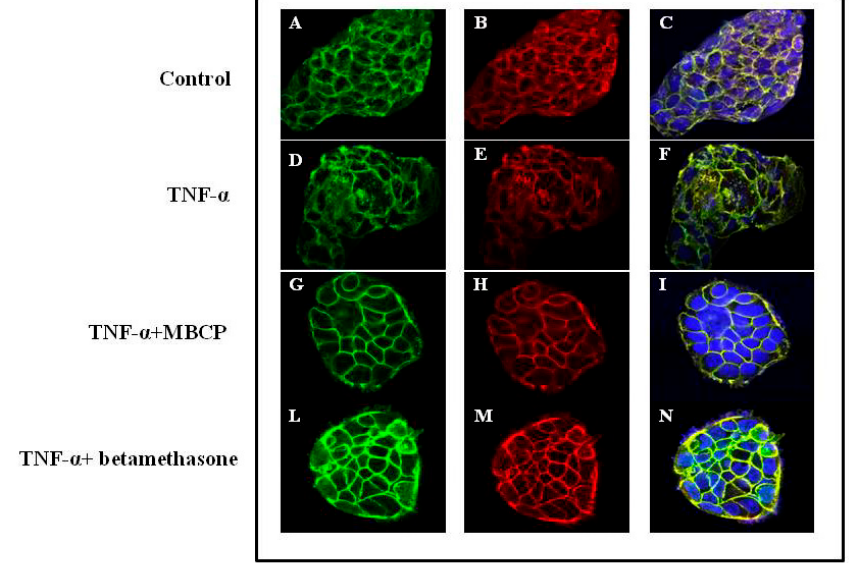
Figure 3. MBCP ameliorates the adherens junctions destructured by TNF- α . Confocal microscopy images of untreated Caco-2 cells (panel ( A – C ), Caco-2 cells treated for 48 h with TNF- α (10 µ M, ( D – F) ), TNF α 10 µ M plus MBCP (18 µ M, ( G – I) ) or with TNF- α (10 µ M) plus betamethasone ( L – N ). On the right, merged image (green, β -catenin; red, E-cadherin; blue, dapi).